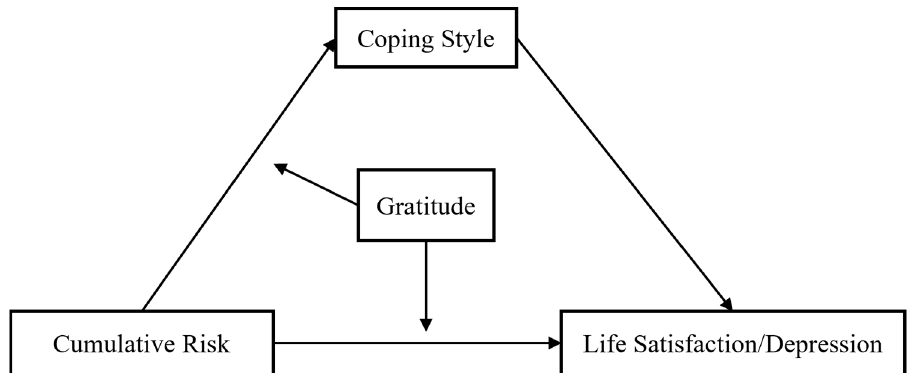
Figure 1. A moderated mediation model.